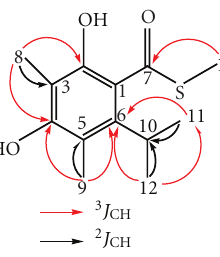
Figure 1: HMBC correlations of 1 .